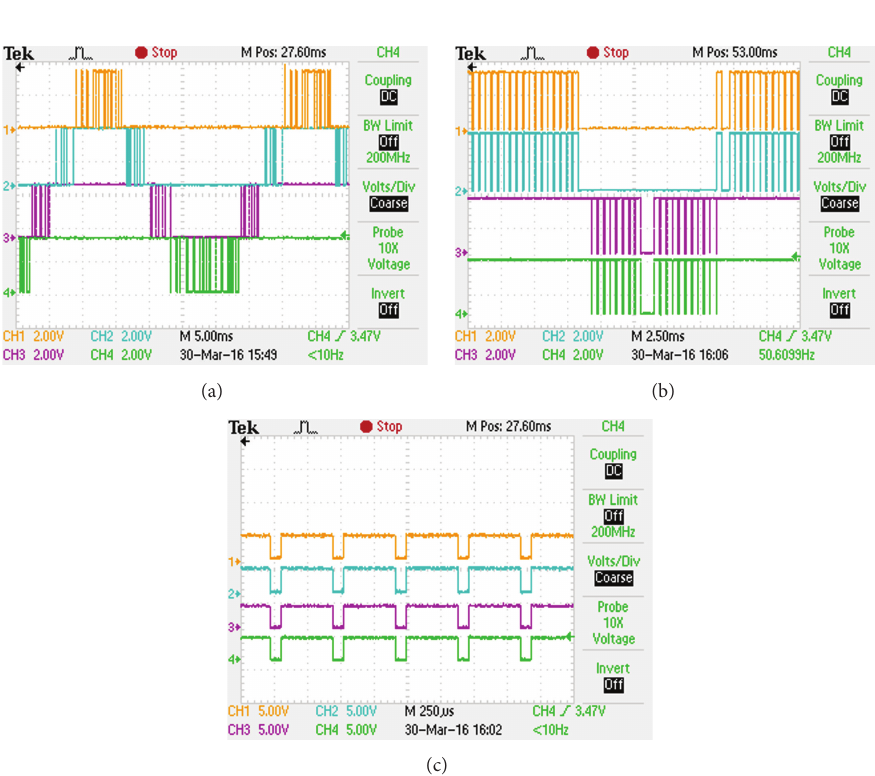
Figure 9: Experimental pulses of five-level inverter as (a) five-level inverter, (b) three-level inverter, and (c) two-level inverter.